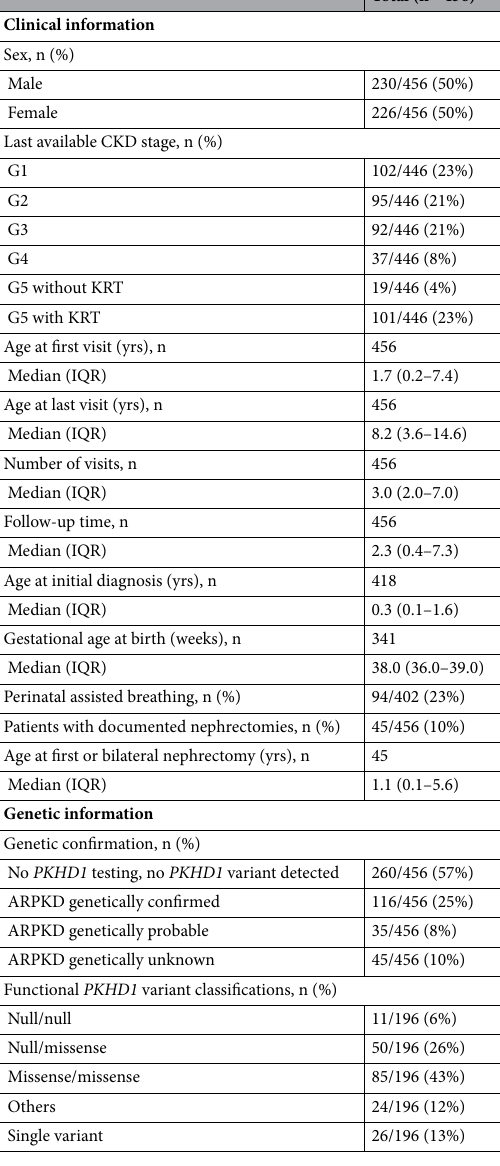
Table 1. Patient characteristics. Percentages have been rounded to whole numbers. Months (mo), years